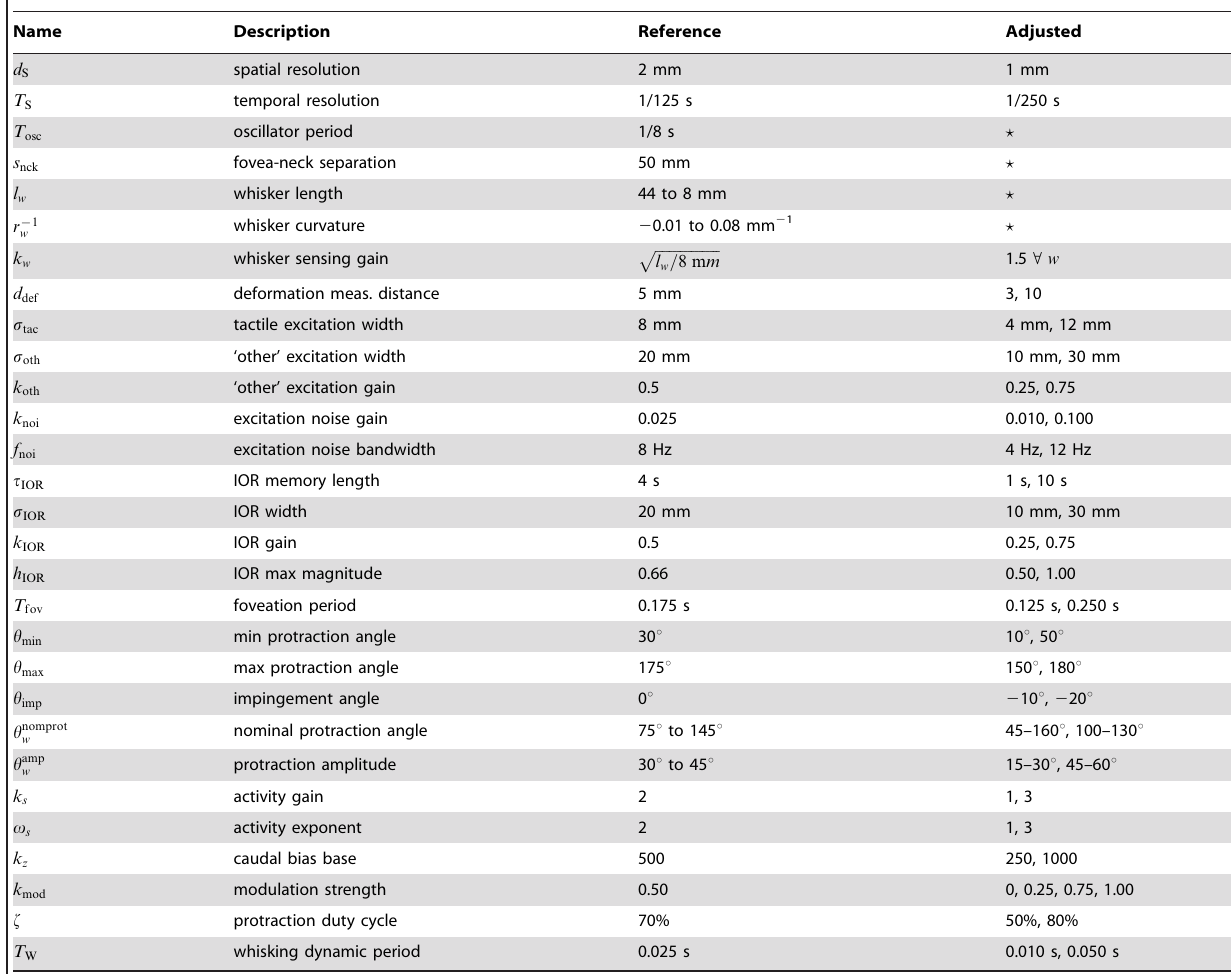
Table 1. Parameters of the